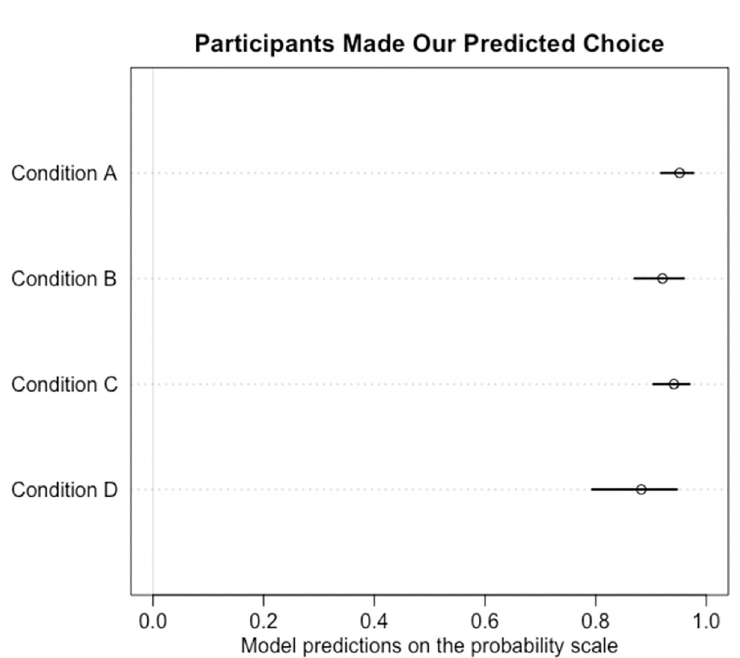
Fig 3. Model predictions for participants choosing the predicted information compared to the alternative information in Round 2 of the four conditions, on the probability scale.